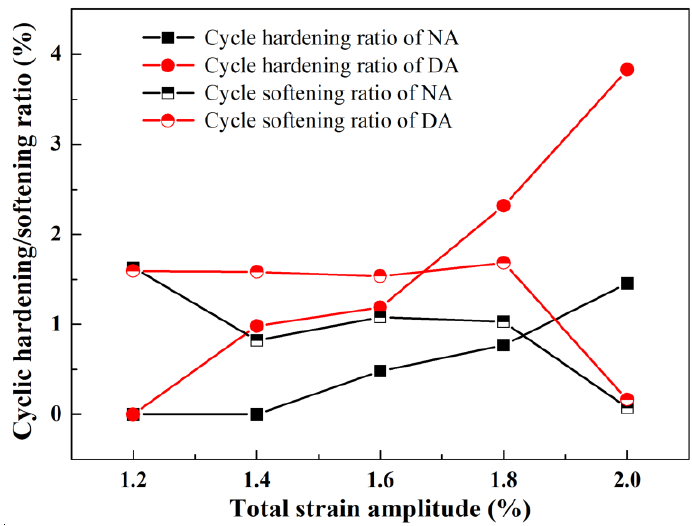
Figure 6. Cyclic hardening ratio and cyclic softening ratio of the alloy under different aging conditions.